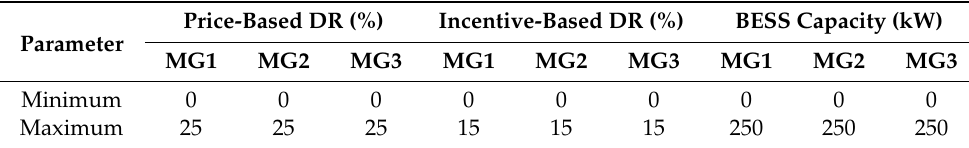
Table 2. Demand response intensity and BESS capacity range in each microgrid.